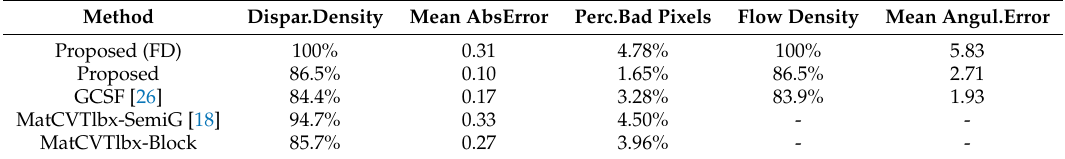
Figure 4. Artificial “Futuristic White-Tower” sequence: estimation error results: ( a ) after only spatial aggregation (5 × 5); ( b ) after spatial aggregation (3 × 3) and scan-line optimization; ( c ) after the application of all steps. Table 2. Comparative results for the “Futuristic White-Tower” sequence. GCSF, Growing Correspondence Seeds for scene Flow; FD, Full